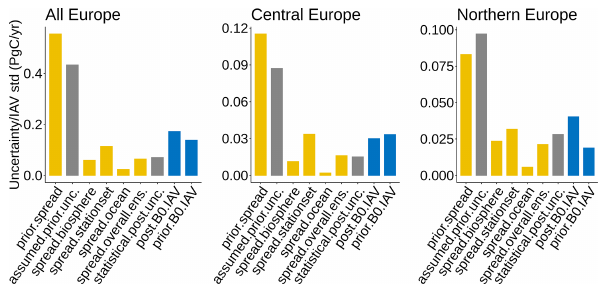
Figure 5. Spread uncertainties calculated from three inversion en- sembles of biosphere, ocean, and station set (yellow bars). Grey bars refer to the statistical uncertainties, and blue bars denote the stan- dard deviations of